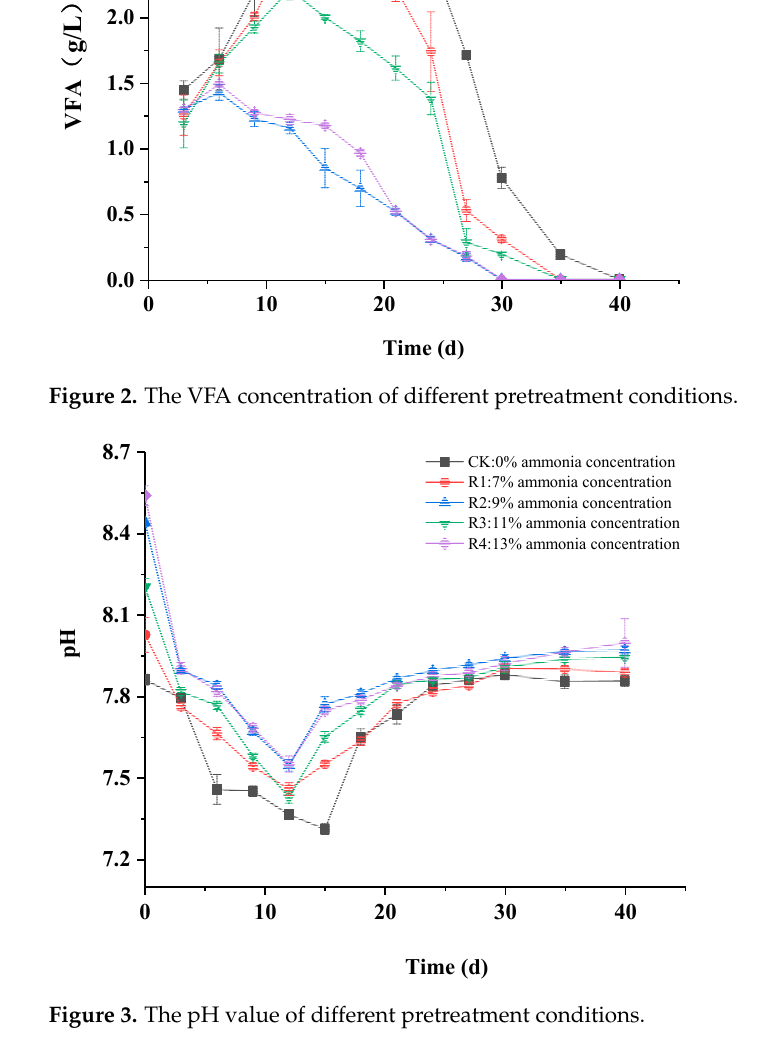
Figure 3. The pH value of different pretreatment conditions.